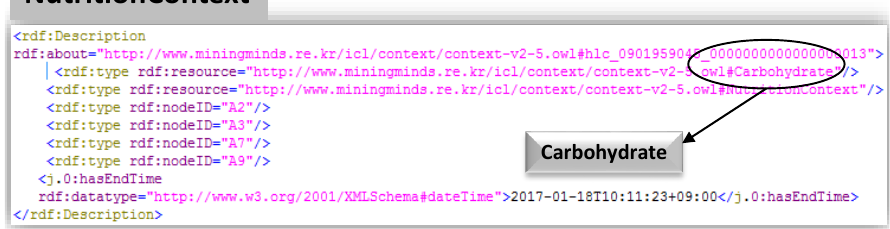
Figure 11. Inferred NutritionContext: Carbohydrate (Major Nutrient) in Rice Fooditem